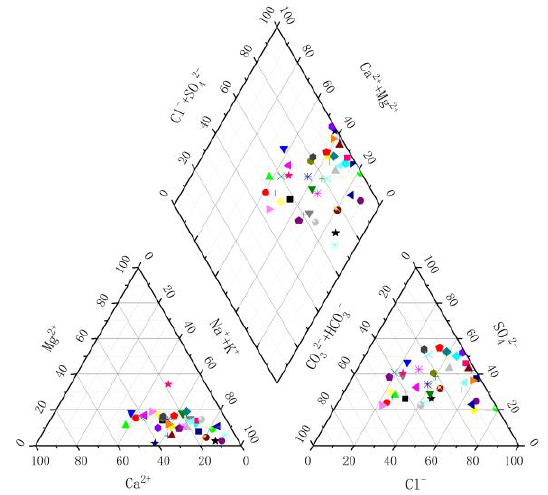
Figure 2. Piper diagram of the groundwater.